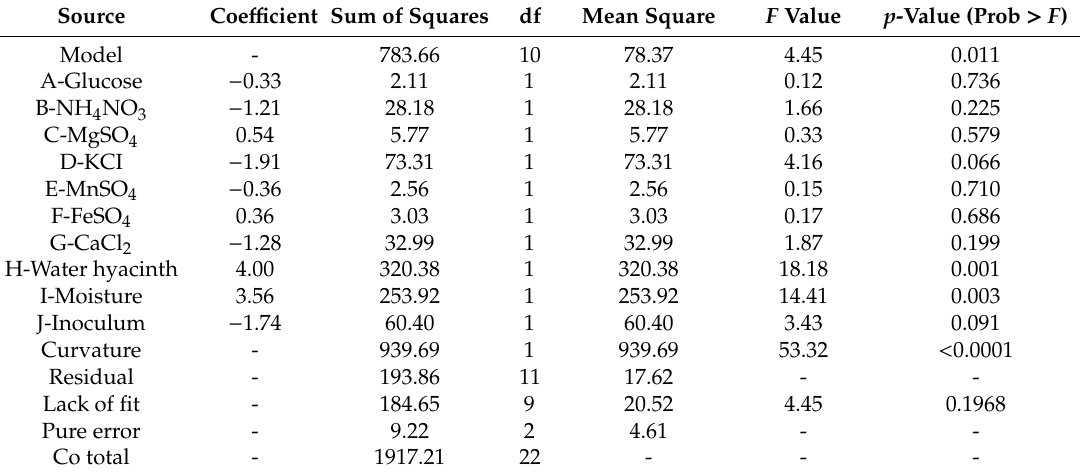
Table 4. Data analysis ( p -values and coe ffi cients) of ten variables on phytase production of P. adiposa using